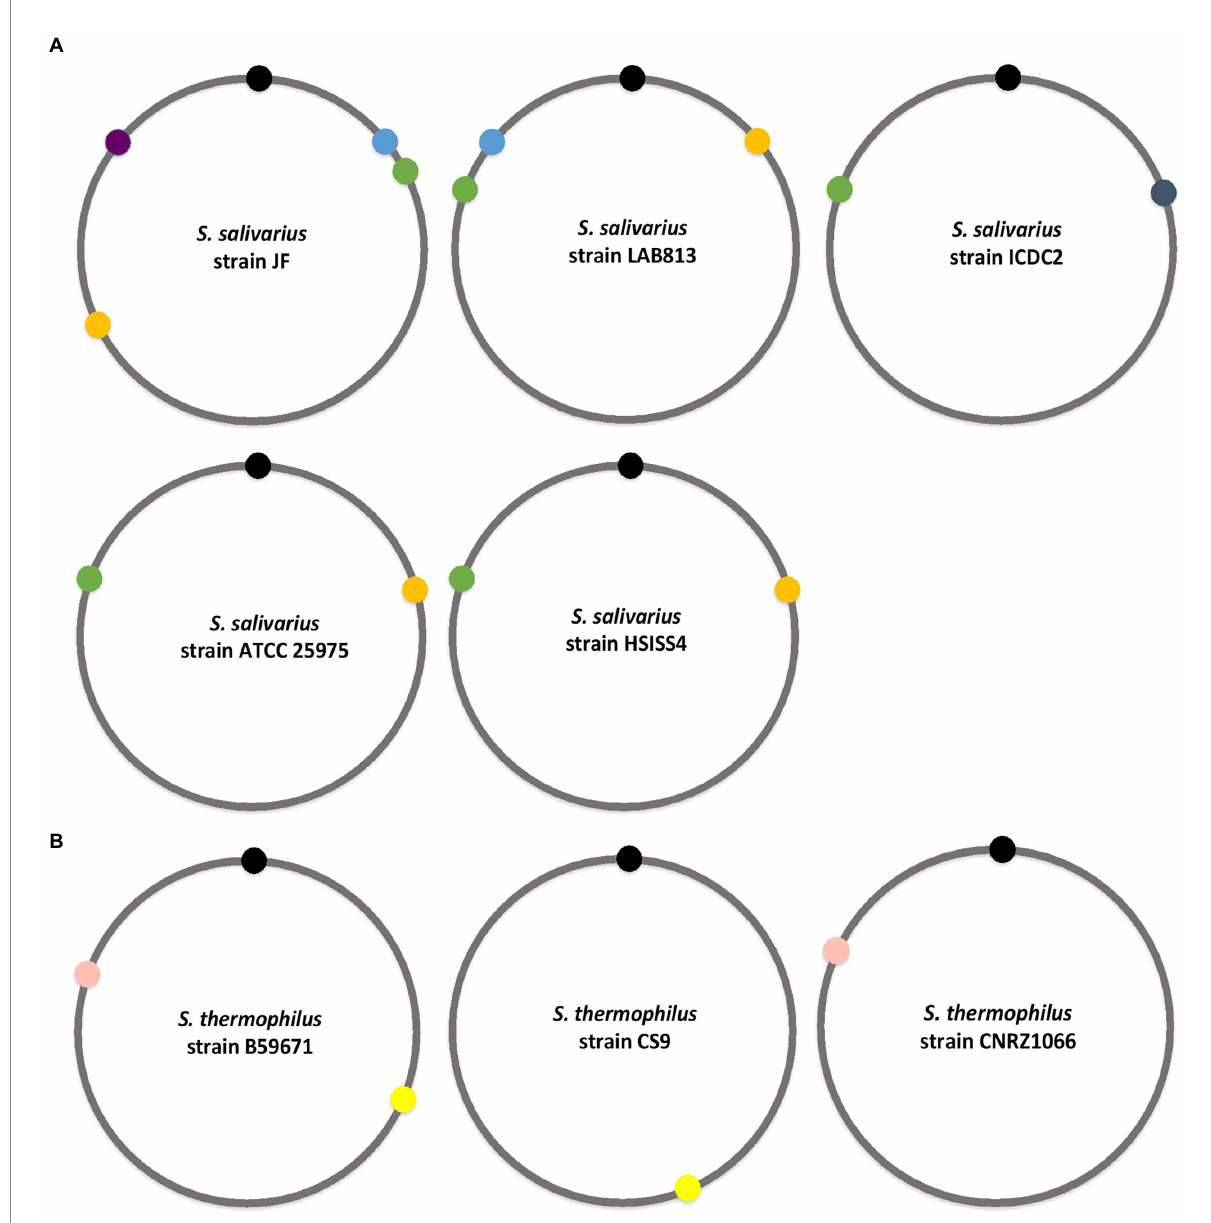
FIGURE 5 Genomic localization of BlpRH systems in salivarious group. (A) Localization of BlpRH systems on the genomes of various S. salivarius strains containing two or more BlpRH systems. (B) Localization of BlpRH systems in S. thermophilus strains. Similar color indicates similar systems. Black circle indicates the position of DnaA